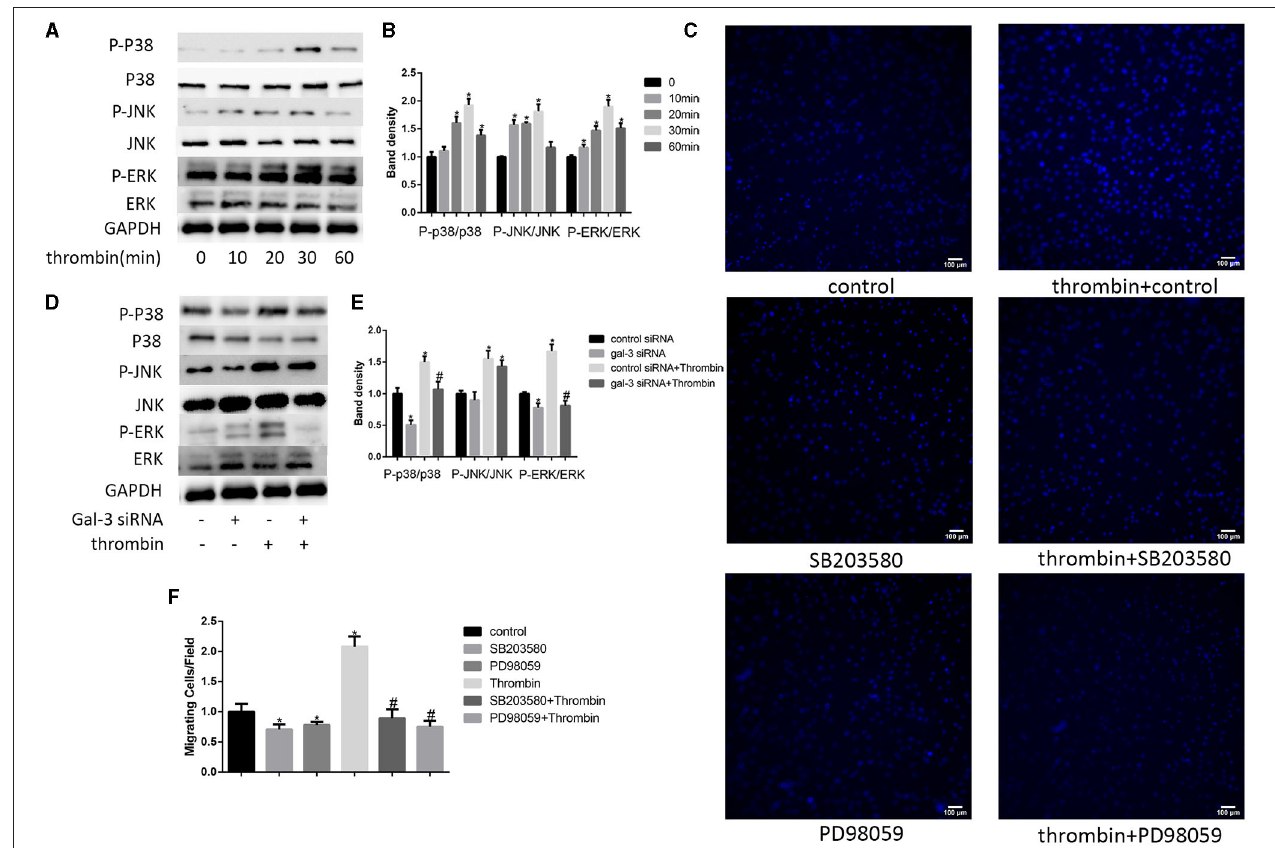
FIGURE 3 | ERK/P38 signaling pathway mediates thrombin effects in VSMCs. Time dependence of thrombin-mediated MAPK signaling pathway activation in VSMCs. Cells were treated with 2 U/ml thrombin over a range of times (0–60min), and the expression of JNK, p-JNK, ERK, p-ERK, p38, and p-p38 was measured by Western blot (A,B) . After transfection with either control or gal-3 siRNA for 24h, VSMCs were incubated for 30min in the absence or presence of thrombin (2 U/ml), and the expression of JNK, p-JNK, ERK, p-ERK, p38, and p-p38 was measured by Western blot again. Western blot results are shown (D,E) . Quantification of the results is given in the right panel. Band density of native VSMCs was defined as a control and considered to 1. * p < 0.05 compared with control. After incubated with either SB203580 or PD98059, VSMCs were added in the upper chamber. After treatment with thrombin (2 U/ml) for 24h in the lower chamber, migrated cells from the upper chamber to the lower surface were counted in five non-overlapping fields under a microscope ( × 100) (C,F) . Native VSMCs were chosen as a reference and set to 1. * p < 0.05 vs. control; # p < 0.05 vs. thrombin.